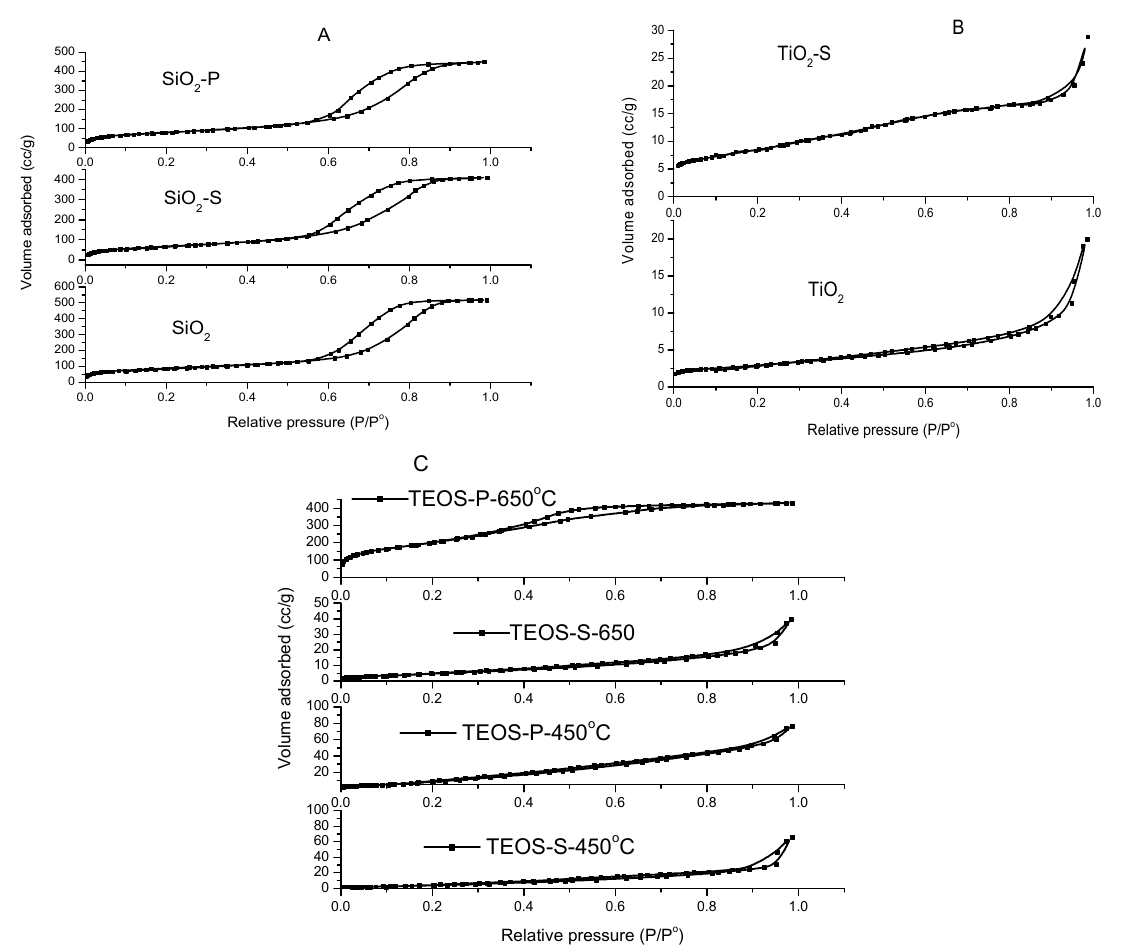
Figure 6. Nitrogen adsorption—desorption isotherm of different catalysts. Plot ( A ) silica, sulfated silica, and phosphated silica; plot ( B ) titania, and sulfated titania; plot ( C ) silica prepared from TEOS treated with sulfuric and phosphoric acid calcined at 450 and 650 °C.